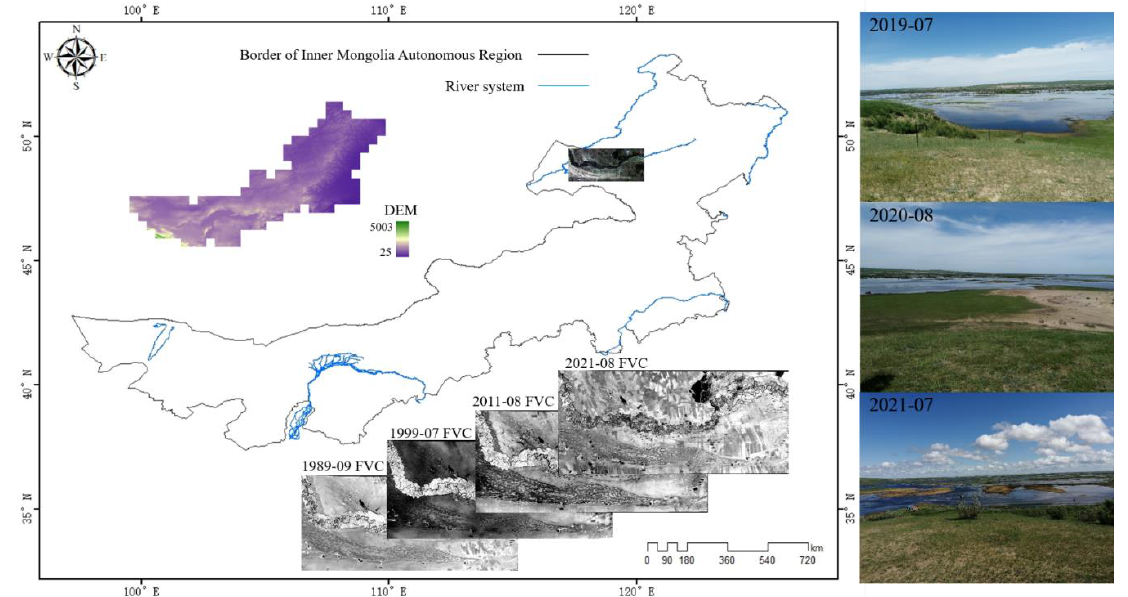
Figure 1. Study area location.